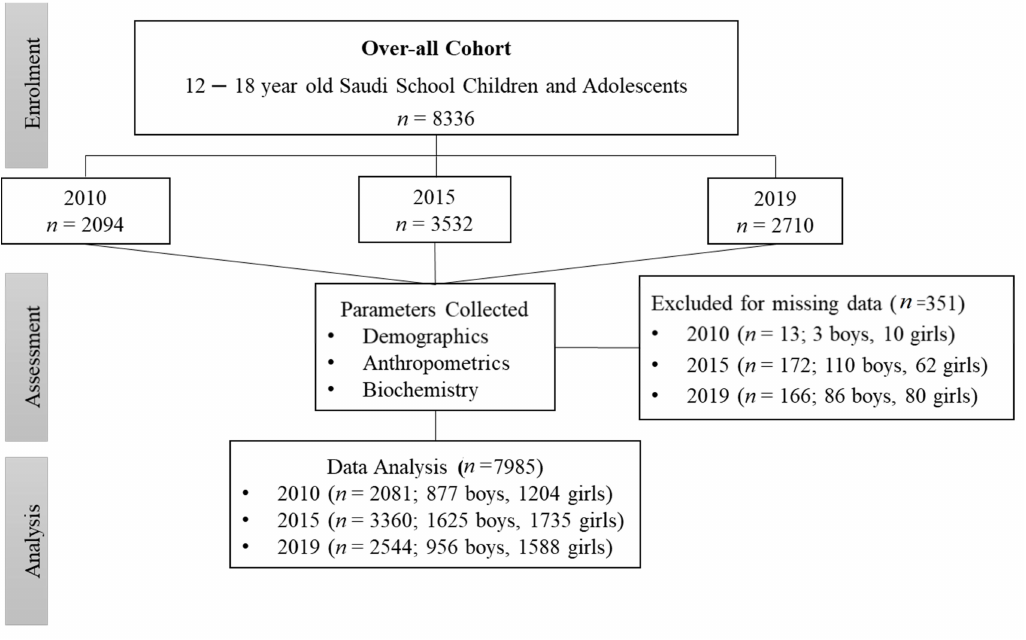
Figure 1. Flowchart of the